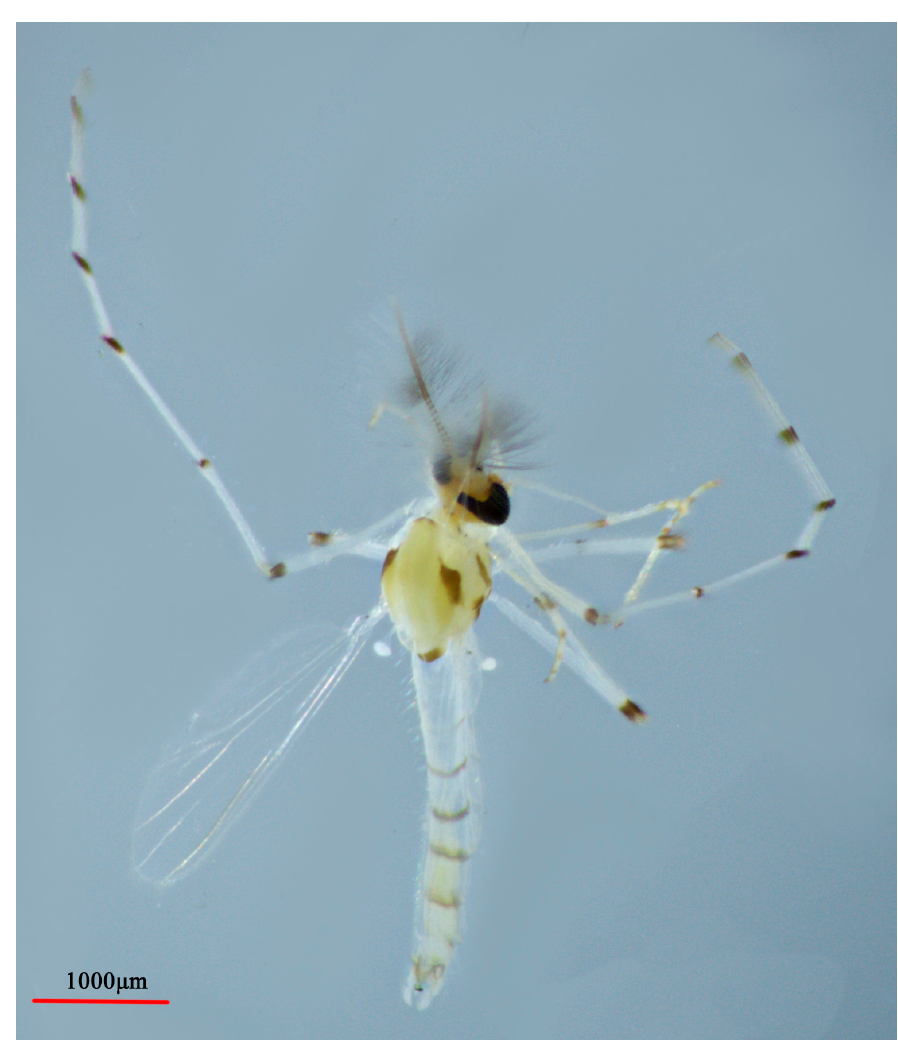
Figure 14. Male adult (holotype, in dorsal view) of Microtendipes tuberosus Qi & Wang. Microtendipes tuberosus Qi & Wang 2006: 43. Microtendipes tuberosus Qi & Wang 2006: